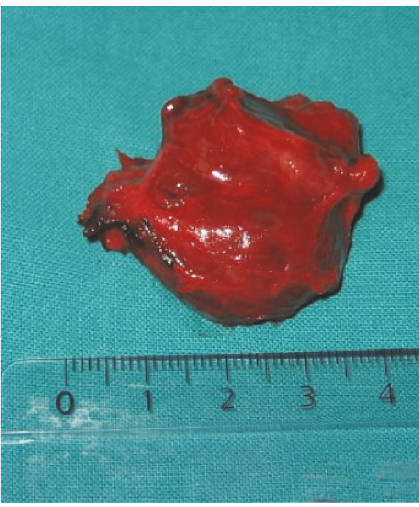
Figure 9: The right carotid triangle with carotid body paragan- glioma.